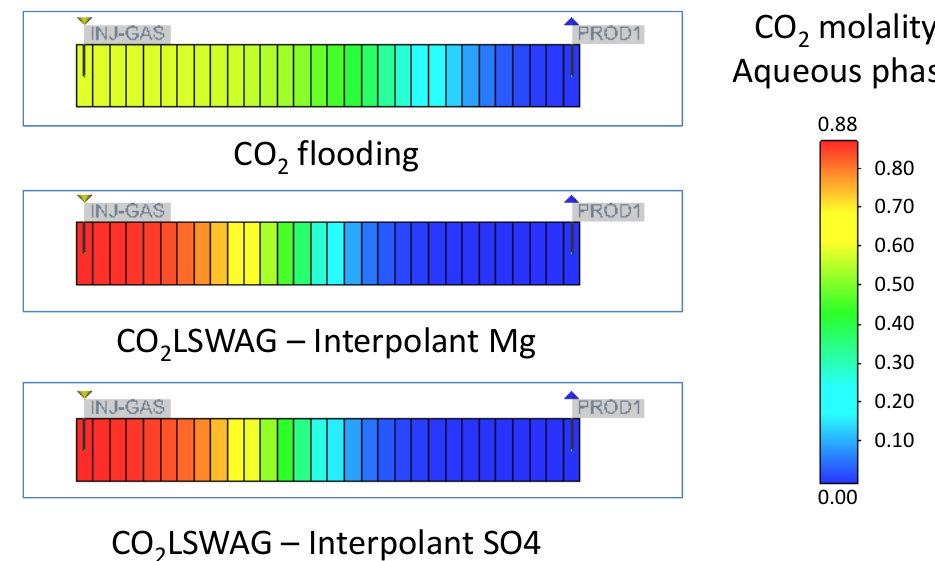
Figure 8. CO 2 molality in the aqueous phase for continuous CO 2 injection and CO 2 -LSWAG consid- ering Mg and SO 4 as ion interpolants—10 porous volumes injected.